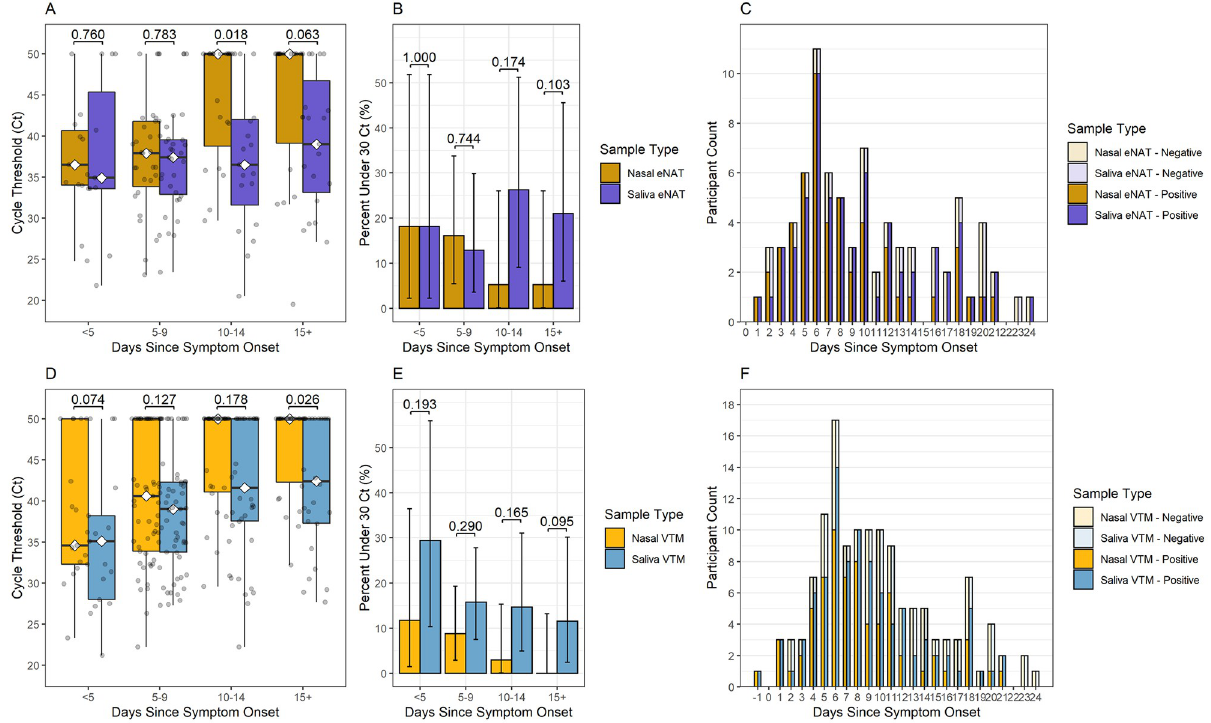
Fig 4. Controlling for media type and volume differences. SARS-CoV-2 longevity in saliva versus nasal specimens in eNAT media, by (A) Ct values, (B) percent of Ct values under 30 and (C) number of positive and negative test results for saliva and nasal swabs over days since symptom onset (n = 80 observations from 45 patients). SARS-CoV-2 longevity in saliva swabbed in VTM media versus nasal swabs in VTM media, by (D) Ct values, (E) percent of Ct values under 30 and (F) number of positive and negative test results for saliva and nasal specimens over time intervals in days since symptom onset (n = 134 observations from 86 patients). Comparisons of medians within each timespan were performed using the Wilcoxon signed- rank test and comparisons of proportions between specimen types within each timespan were performed using the McNemar test for correlated